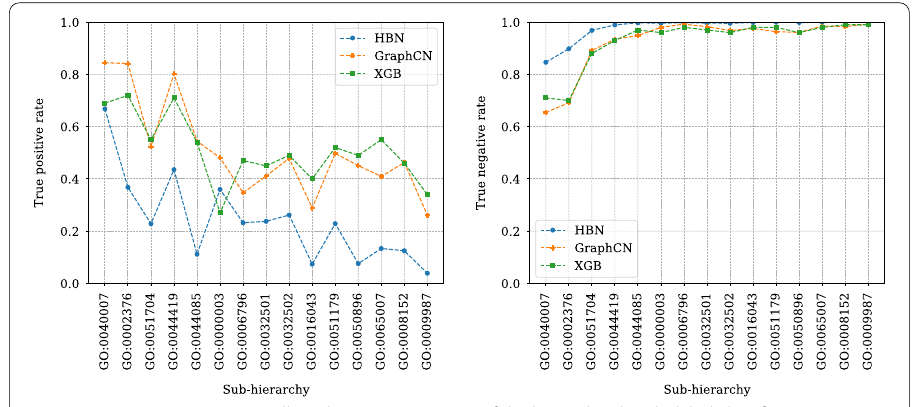
Fig. 5 True positive rate (or recall) and true negative rate of the hierarchical multi-label classification approach with XGBoost (XGB) and graph convolutional network (GraphCN) classifiers, and the HBN model for the 15 sub-hierarchies generated for Oryza sativa Japonica